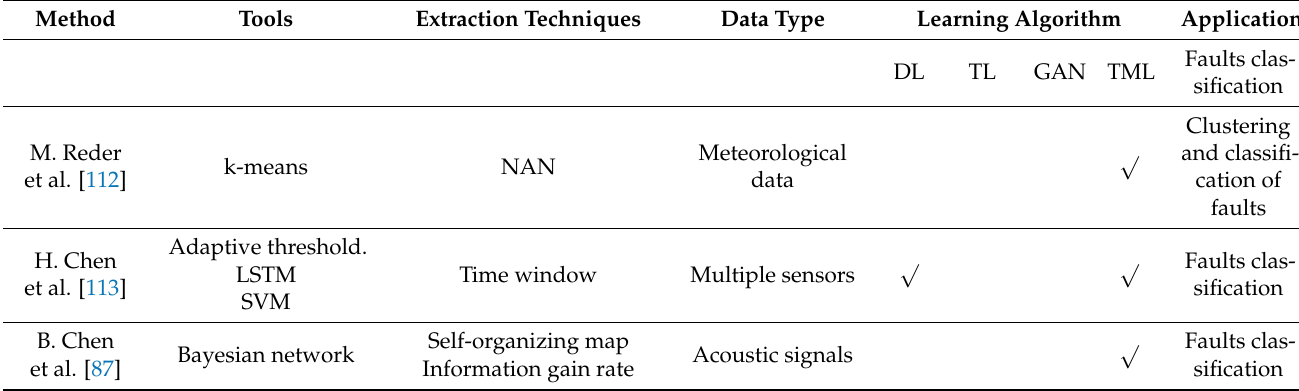
Table 3. Yaw system condition monitoring state of the art review.